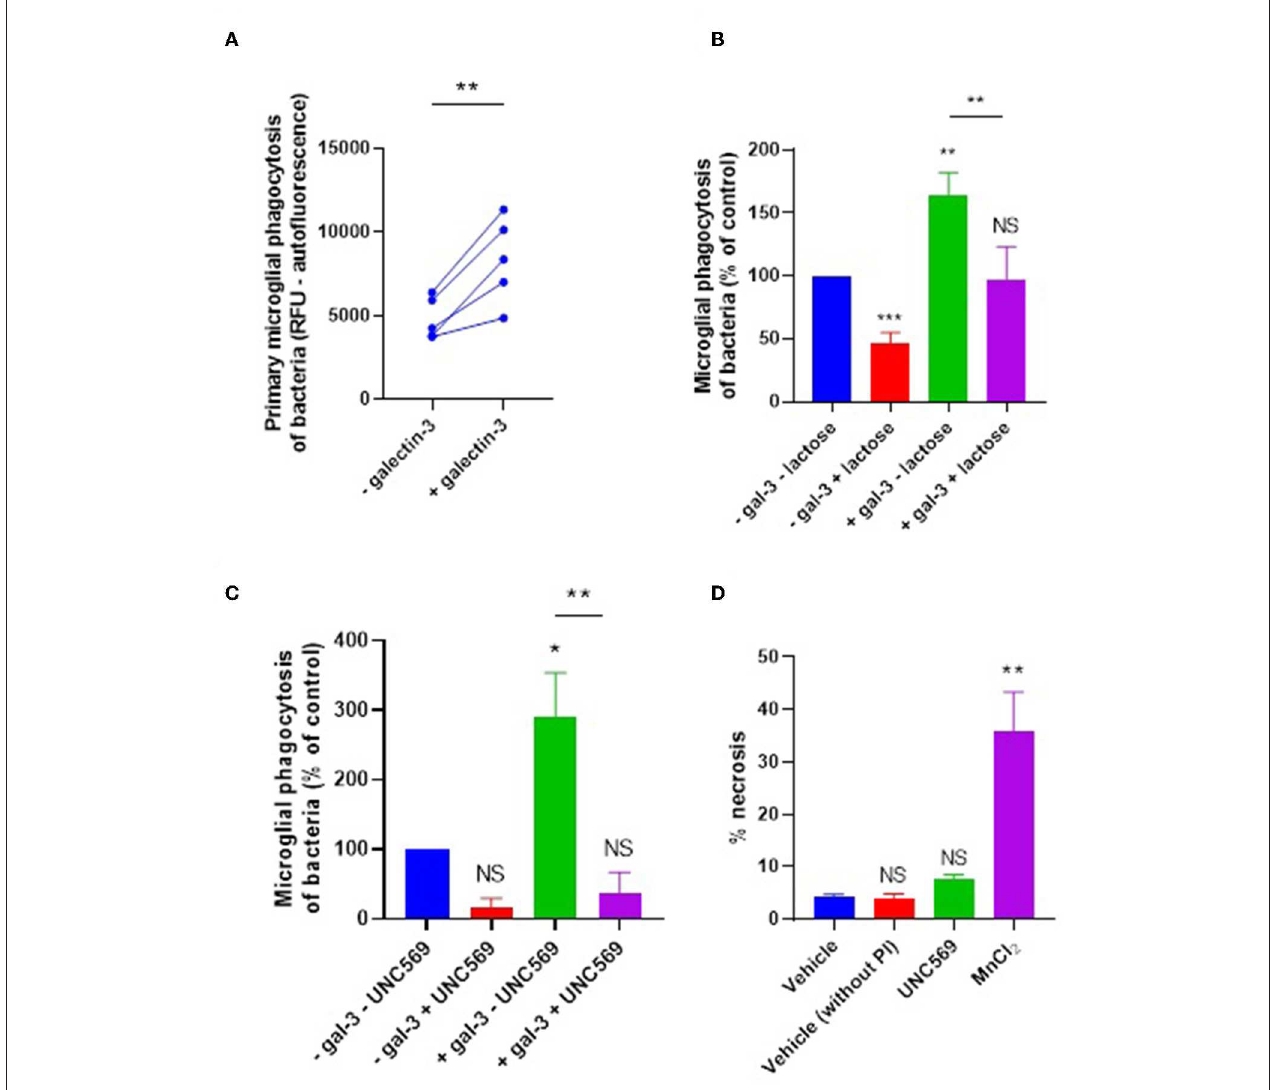
FIGURE 4 | Galectin-3 opsonizes E. coli for microglial phagocytosis. (A) Recombinant galectin-3 (20nM) opsonizes E. coli for microglial phagocytosis when pre-incubated for 90min (and subsequently washed to remove unbound protein). (B,C) Opsonization of E. coli for microglial phagocytosis by recombinant galectin-3 is inhibitable by 50mM lactose when compared to “–gal-3 – lactose” control (B) , or 5 µ M UNC569 (a MerTK inhibitor) when compared to “–gal-3 – UNC569” control (C) (note that a statistically significant difference between “–gal-3 – lactose” and “–gal-3 + lactose” was observed). (D) UNC569 (5 µ M for 2h) does not promote necrotic death of primary rat microglial cells in culture compared to the “vehicle” control, determined by propidium-iodide staining and quantified via flow cytometry. Manganese chloride (MnCl 2 , 1mM) was used as a positive control for necrotic death. Values are means ± SEM of at least three independent experiments. Statistical comparisons were made via one- or two-way ANOVA except for (A) , which was by pair-wise student’s t -test. NS p ≥ 0.05, * p < 0.05, ** p < 0.01, *** p < 0.001 vs. controls, except where indicated by bars over relevant columns.